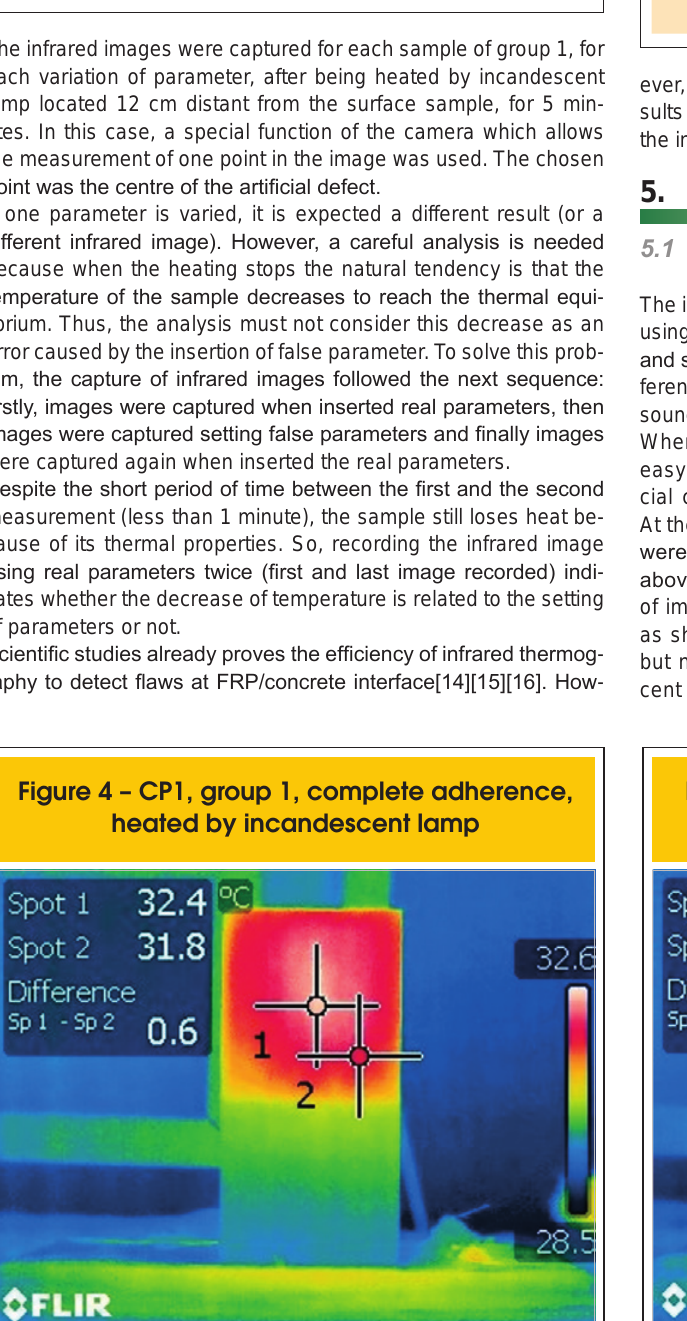
Figure 5 – CP2, group 1, EPS ϕ =2 cm, heated by incandescent